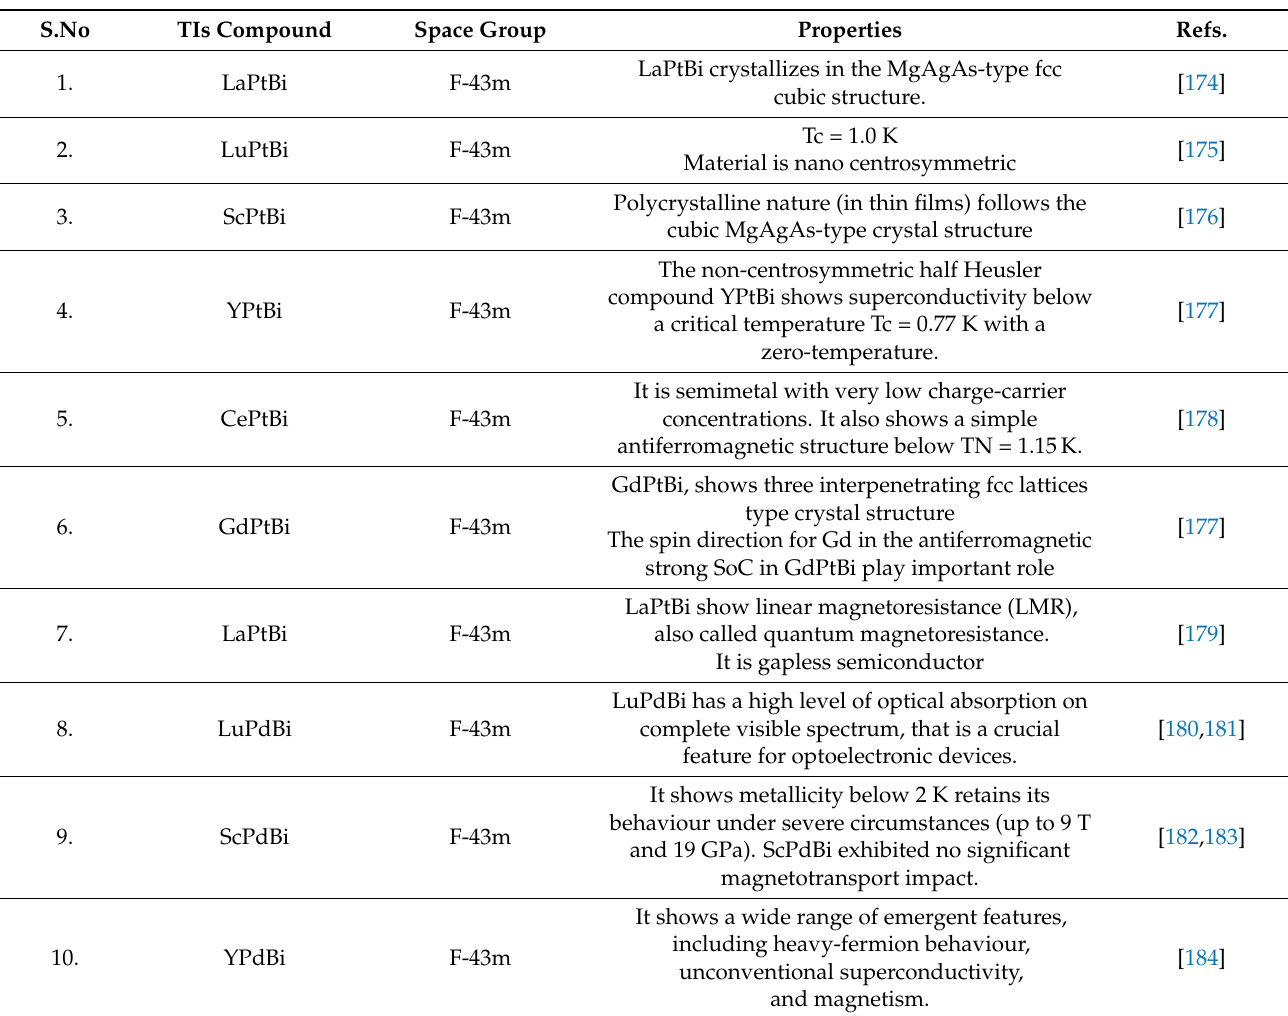
Table 6. Half-Heusler type topological quantum materials based on rare- earth